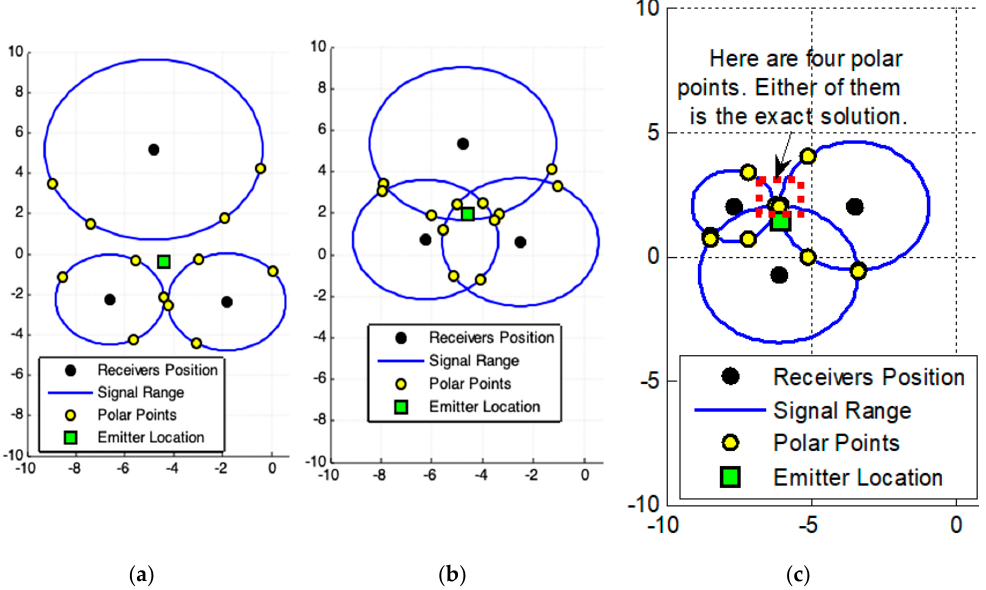
Figure 3. Results produced by Polar-Points Centroid Model (PPC). ( a , b ) show the possible presence of noise in acquired data. ( c ) Represents the best case for acquired data because the signal data are quasi -exact. The red dotted rectangle mark all (four) polar points that belong to all circle lines (signals range). The exact solution is one of these points (see Section 2.1).